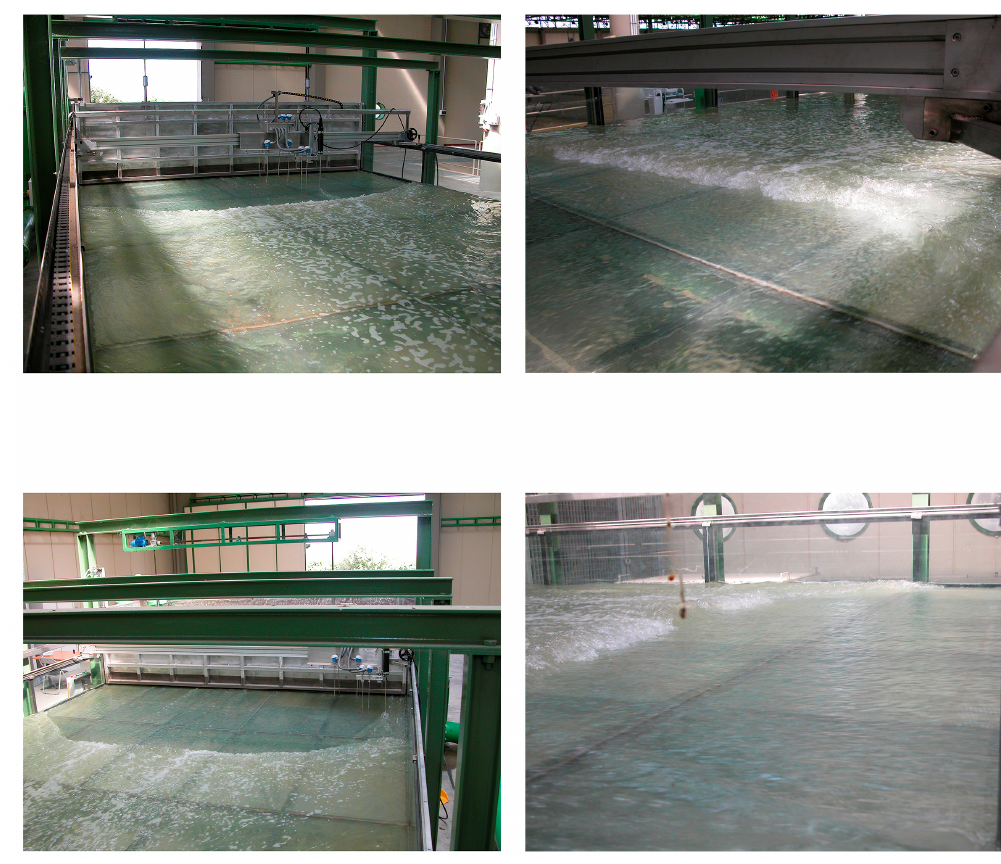
Figure 1. A hydraulic jump in the large channel of the LIC—Coastal Engineering Laboratory of the Polytechnic University of Bari, Italy. (See Video S1 in Supplementary Material).